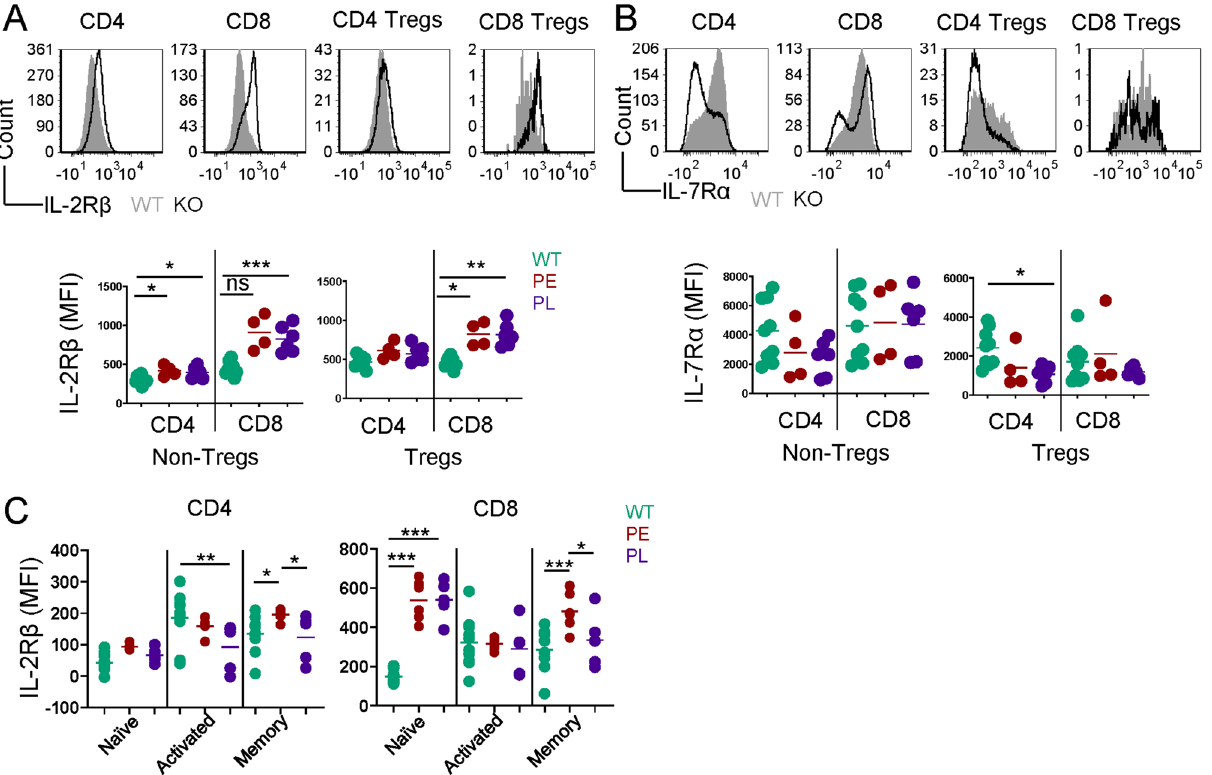
Figure 5. IL-2Rα-KO CD8 T cells express two-fold higher levels of IL-2Rβ than WT CD8 T cells. Representative histograms showing the expression and summary of mean fluorescent intensity (MFI) of ( A ) IL-2Rβ and ( B ) IL-7Rα on CD4, CD8, CD4 Treg, and CD8 Treg cells in spleen of 19-day-old WT and IL-2Rα-KO mice. n = 5–10 mice per experimental group. ( C ) MFI of IL-2Rβ on LN cells from 19-day-old WT and IL-2Rα-KO mice based on activation state as defined in Fig. 2B. n = 5–10 mice per experimental group. Statistics: unpaired Student’s t test; *p < 0.05, **p < 0.01, ***p < 0.001. Non-significant comparisons are not (Supplementary Fig. S6C). While TCR responses were unchanged in the spleen, PE lymphocytes had less sus- tained and weaker peak phosphorylation and PL lymphocytes had slower kinetics and drastically reduced maxi- mum phosphorylation (Supplementary Fig. S6D). Finally, to assess how different PE and PL disease are from each other, PCA was performed on 35 parameters gathered from the same mice, including data from the spleen, bone marrow, peripheral blood, and lymph nodes. WT and IL-2Rα-KO mice clearly separate, as expected; however, PE and PL IL-2Rα-KO mice did not (Fig. 8A). Following regression tree analysis to identify the most useful separating variables, PCA was performed again. As before, WT and IL-2Rα-KO mice were separated, but importantly PE and PL IL-2Rα-KO mice were also distinct (Fig. 8A). In the refined PCA analysis PE, PL, and late endpoint IL-2Rα-KO mice separated from each other. Interestingly, PL on day 19 and PL endpoint (end stage disease) overlap almost completely in PC1, but separate